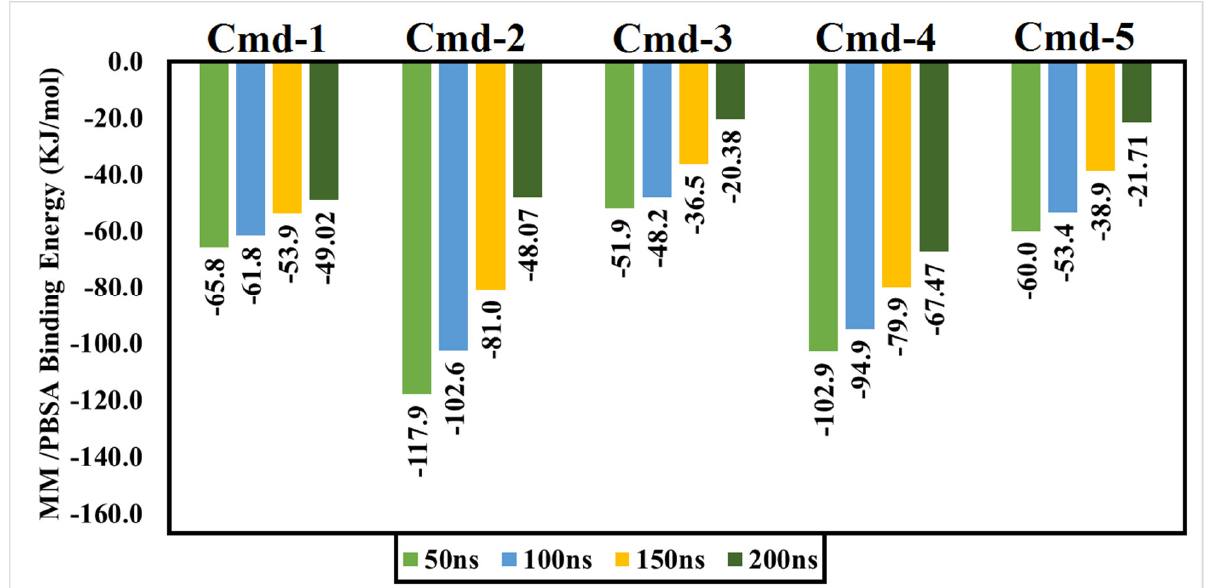
Figure 3. Estimated MM/PBSA binding energies for the best six drug candidates as Omicron BA.1 inhibitors.